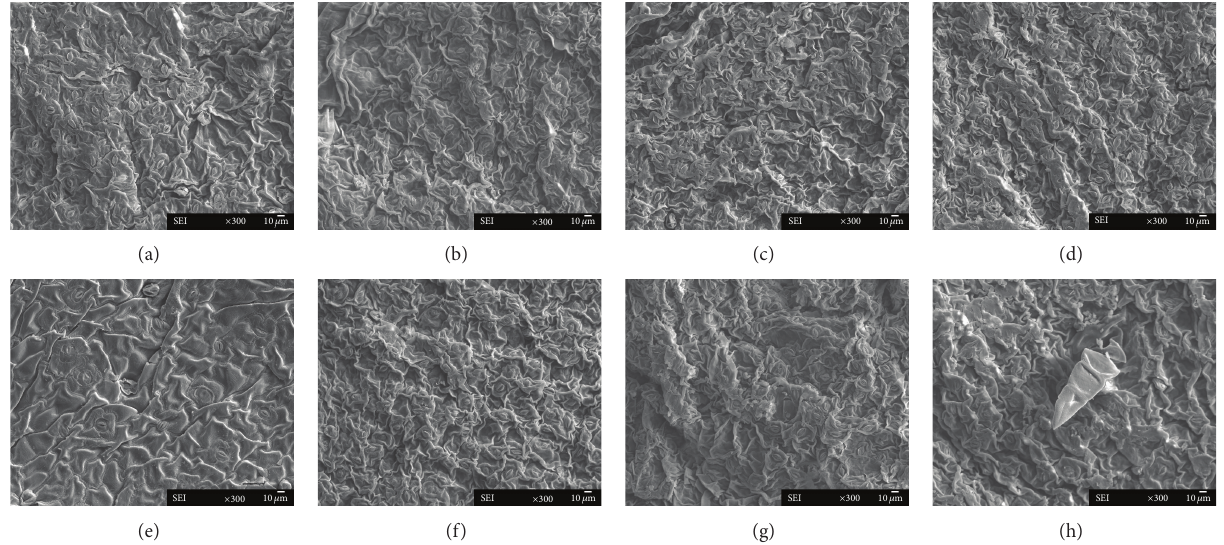
Figure 4: Scanning electron microscopic analysis of A. multiflora leaves treated with silicon and NaCl. (a) MS medium, (b) MS + 1.8 mM Si, (c) MS + 3.6 mM Si, (d) MS + 7.2mM Si, (e) MS + 50 mM NaCl, (f) MS + 50 mM NaCl + 1.8mM Si, (g) MS + 50 mM NaCl + 3.6 mM Si, and (h) MS + 50mM NaCl + 7.2mM Si.